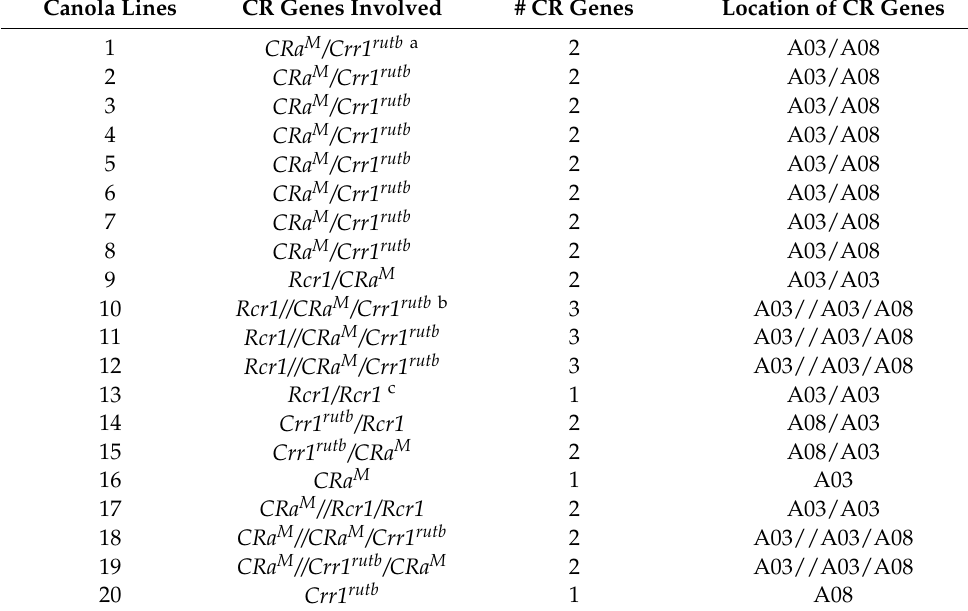
Table 1. Canola inbred/hybrid lines carrying single, double and triple CR genes tested against three field collections (L-G1, L-G2 and L-G3) of pathotype X of Plasmodiophora brassicae